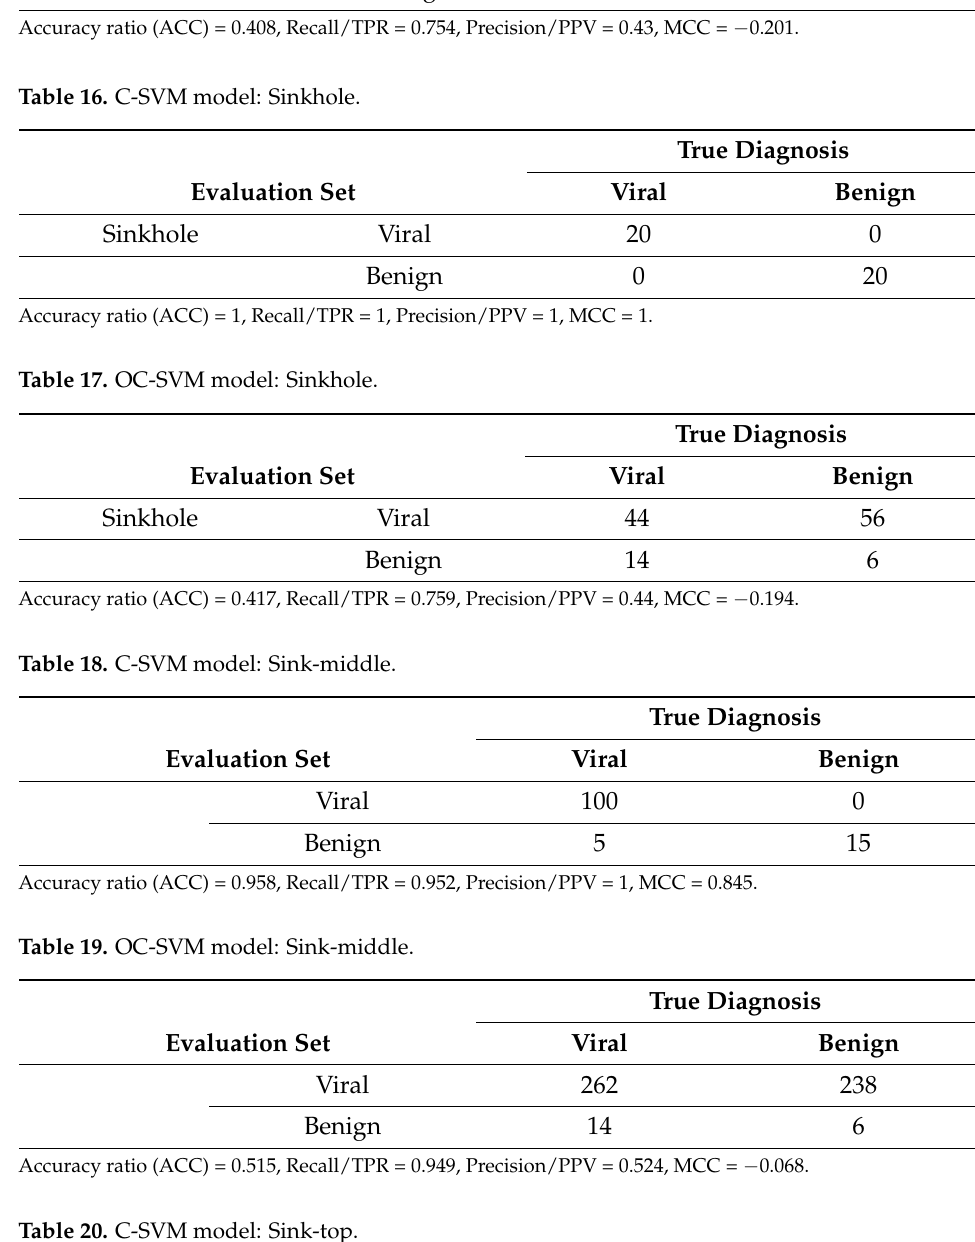
Table 20. C-SVM model: Sink-top. True Diagnosis Evaluation Set Viral Benign Viral 710 90 Benign 59